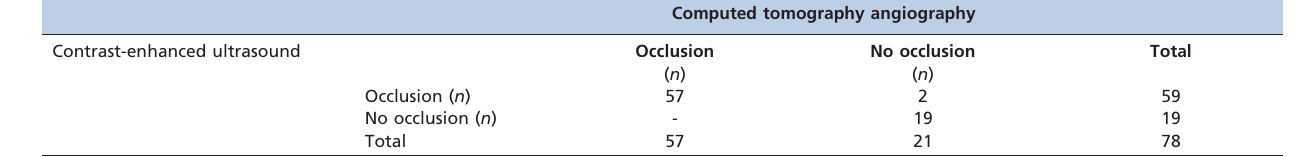
Table 2 - Comparison between contrast-enhanced ultrasound and computed tomography angiography in the evaluation of the 78 internal carotid arteries classified as occluded by Doppler ultrasound (without